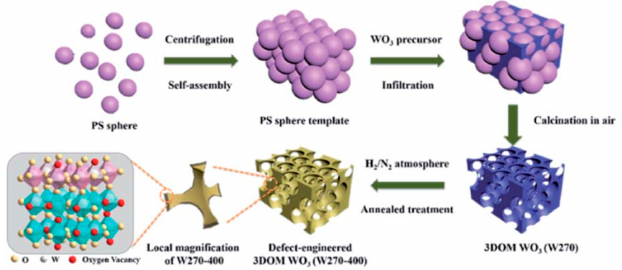
Figure 2. Schematic illustration of the preparation of 3DOM WO 3 [24].